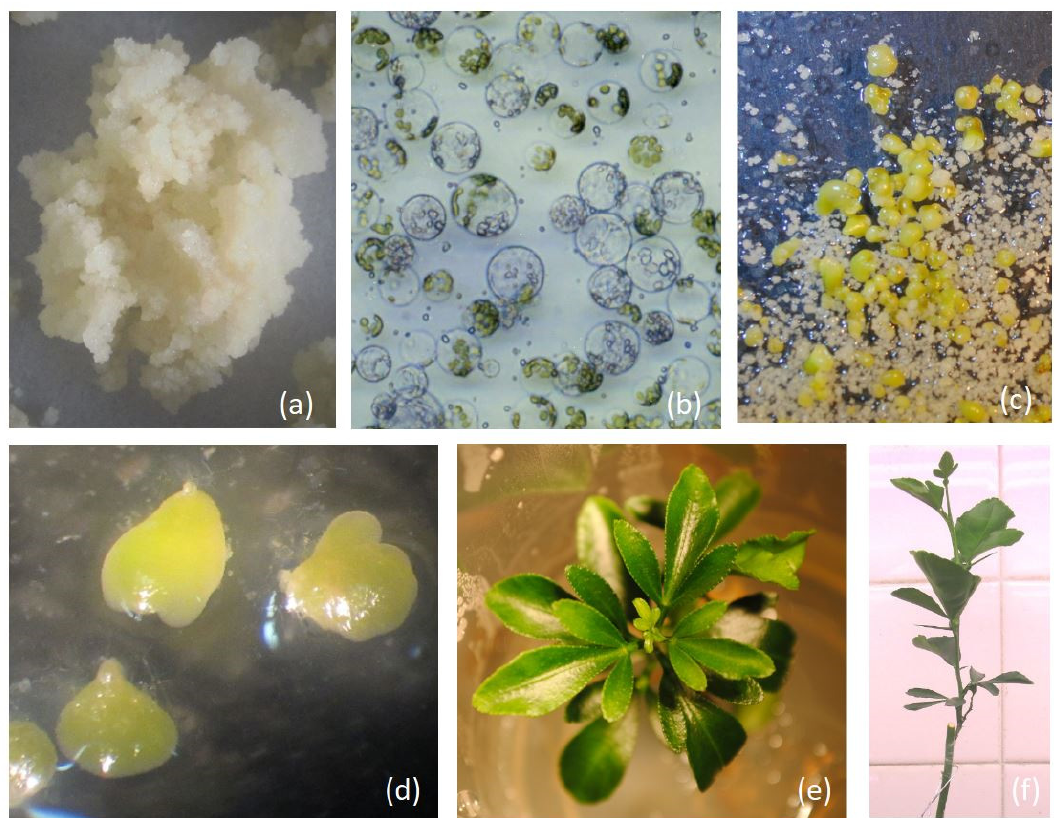
Figure 1. Process of somatic hybridization and plant regeneration: ( a ) embryogenic callus line of Shamouti sweet orange; ( b ) protoplast fused after three pulses (35 µs) of 220 V (DC); ( c ) pro-embryo 1 month after fusion; ( d ) heart-shaped embryos two month after fusion; ( e ) in vitro plantlet of Cleopatra + Winter Haven tetraploid somatic hybrid; ( f ) grafted plant of Shamouti sweet orange + 4475 citrumelo-Chios cybrid tetraploid somatic hybrid.